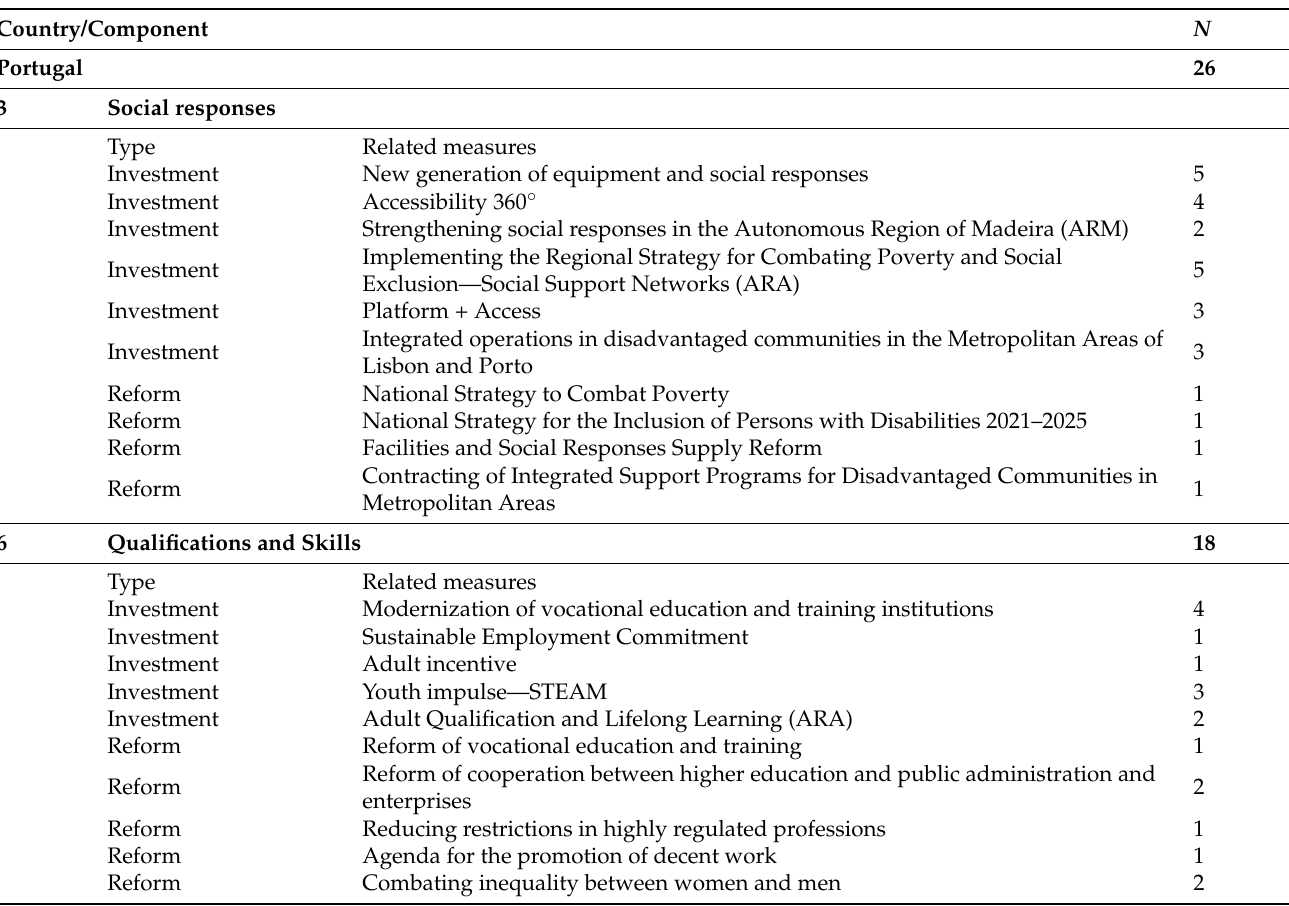
Table 7. Social and employment protection measures in the Portuguese recovery and resilience plan.